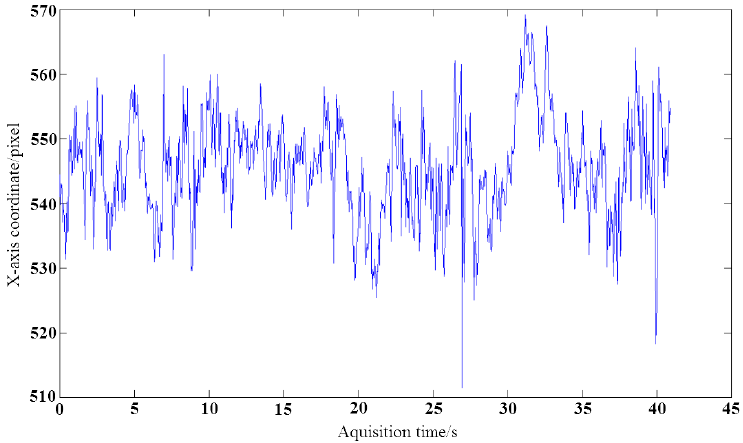
Figure 17. Laser spot position information of 1000 spot images.